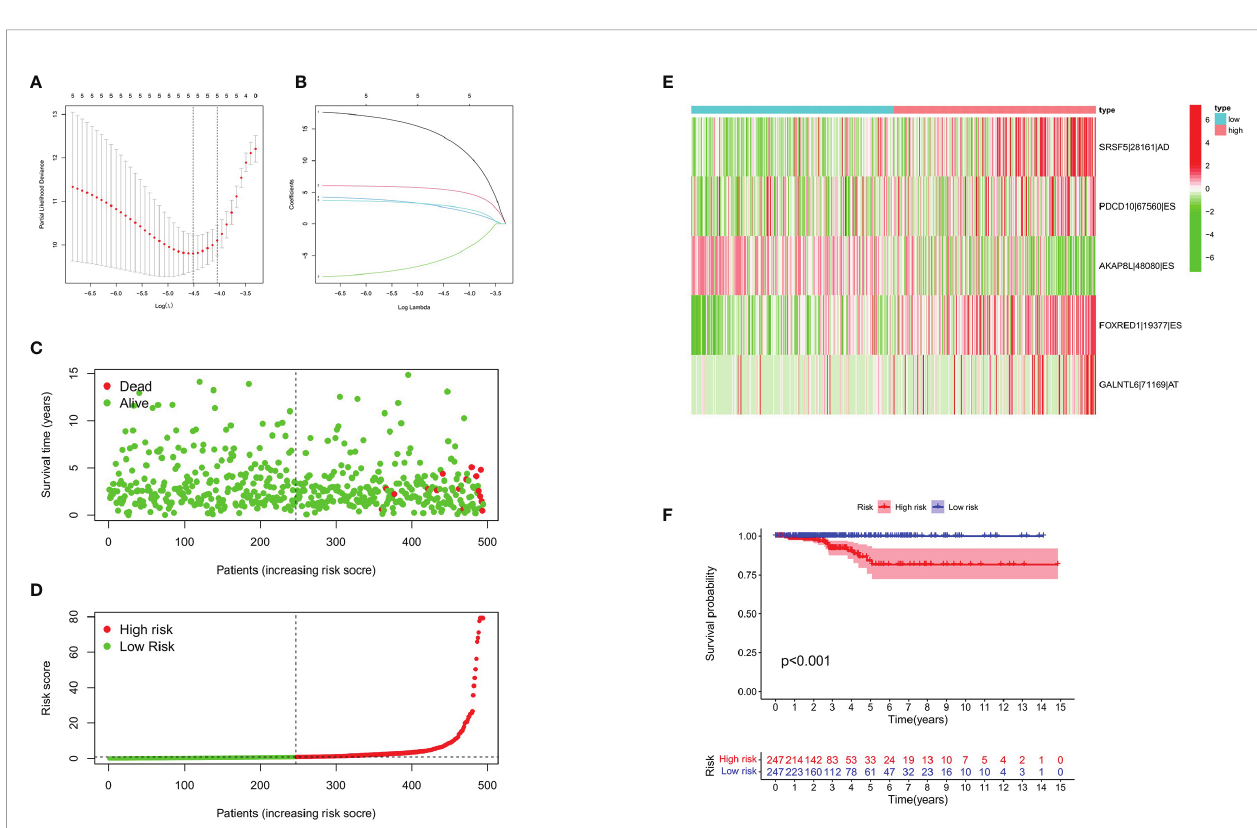
FIGURE 4 | Construction of prognostic signature based on AS events. (A) LASSO coef fi cient of selected OS-related AS events. (B) Lambda graph of the LASSO regression signature. (C, D) Survival time and survival status of patients in the high- and the low-risk groups. (E) Heat map showed the differential expression of fi ve AS events between the high- and the low-risk groups. (F) K-M Survival curve of patients in the high- and the low-risk